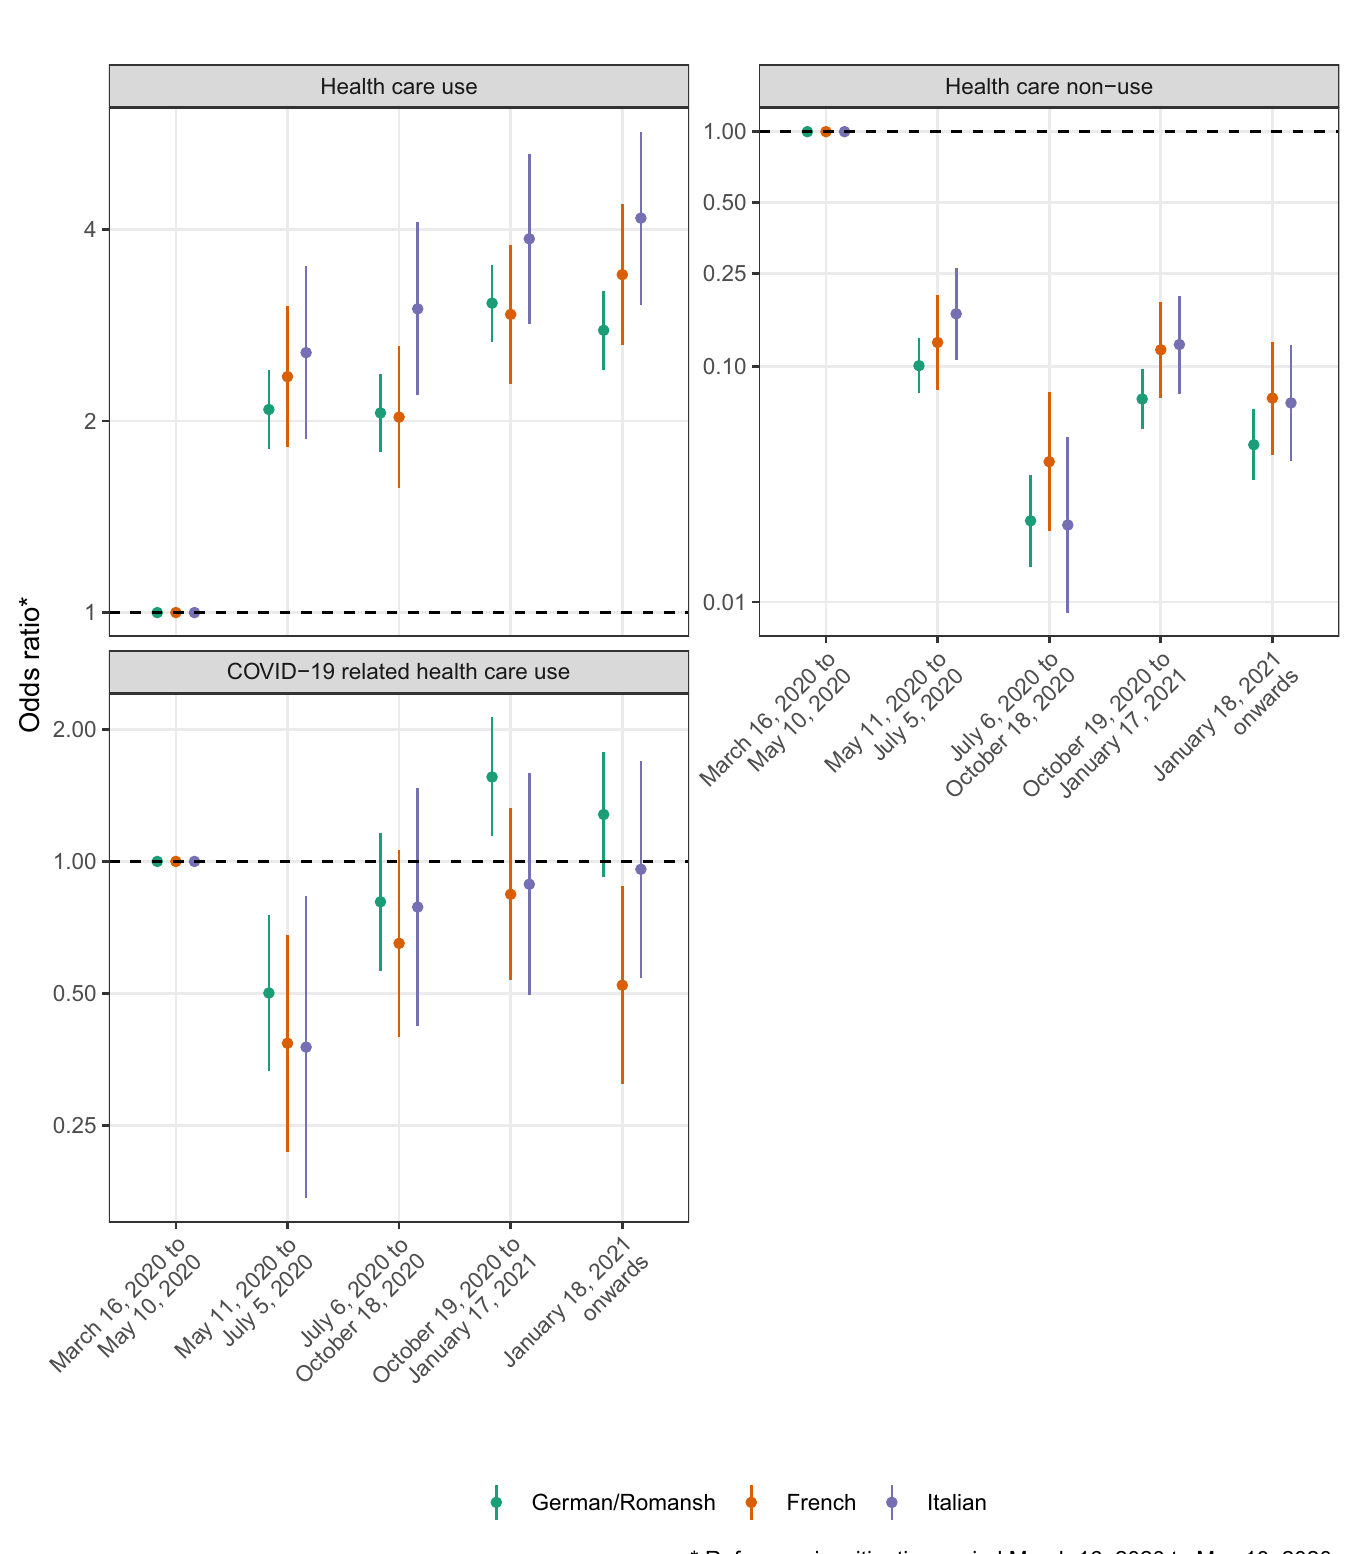
Fig 7. Results from adjusted hierarchical logistic regression models for the study outcome domain of health care use, by mitigation period, language region and for the whole of Switzerland.